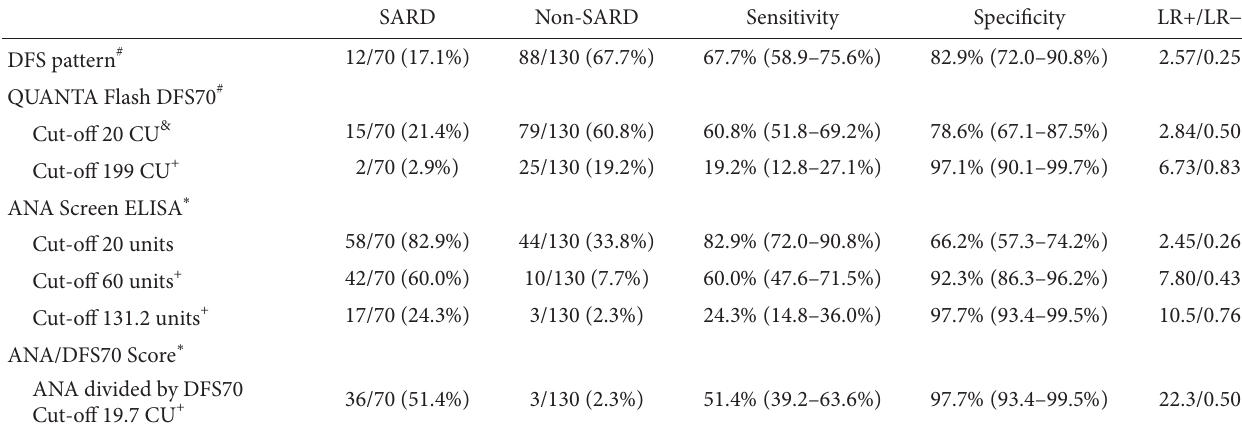
T 2: Discrimination of SARD and non-SARD using ANA ELISA, anti-DFS70 CIA, and ANA/DFS70 score (ANA divided by DFS70); different